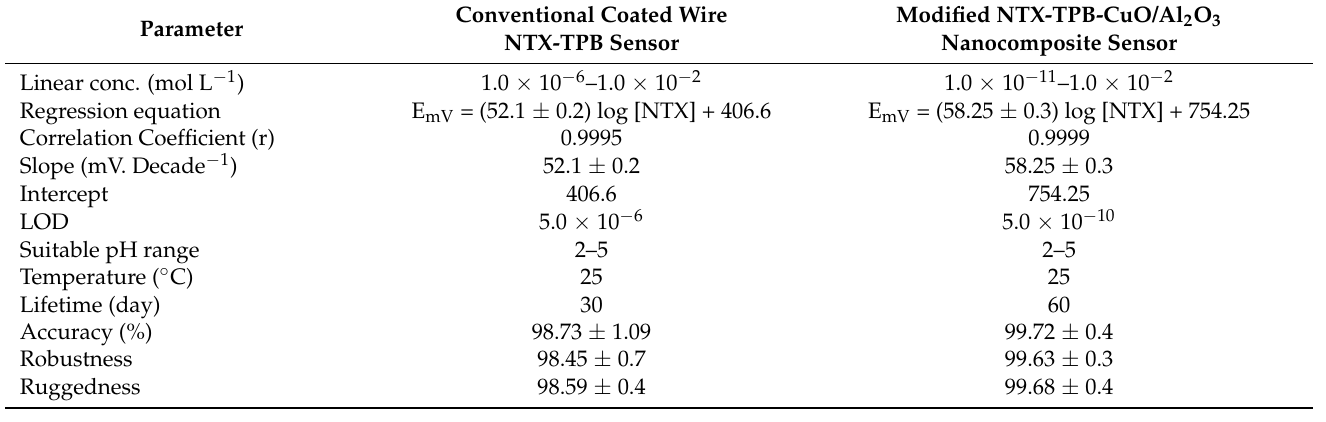
Table 1. Critical response features of designed conventional coated wire naltrexone -tetraphenyl borate (NTX-TPB) and modified NTX-TPB-CuO/Al 2 O 3 nanocomposite sensors.